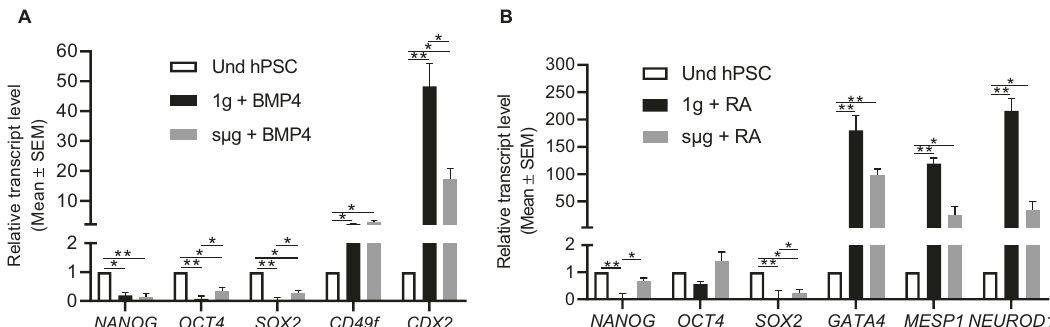
Fig. 3 Differentiation of hPSCs is reduced under simulated microgravity (s μ g) conditions. hPSCs were cultured under s μ g or 1g for 48 h with a medium that sustains their self-renewal, followed by a further 48 h of culture with a differentiation medium to induce ( A ) trophectoderm and ( B ) neuroectoderm differentiation. RT-qPCR analysis of representative genes related to pluripotency, trophectoderm, and neuroectoderm indicated that differentiation under s μ g condition is reduced compared to 1g condition. * p < 0.05, ** p < 0.005 ( n = 3; unpaired t test). Error bars in graphs represent the SEM of the group.